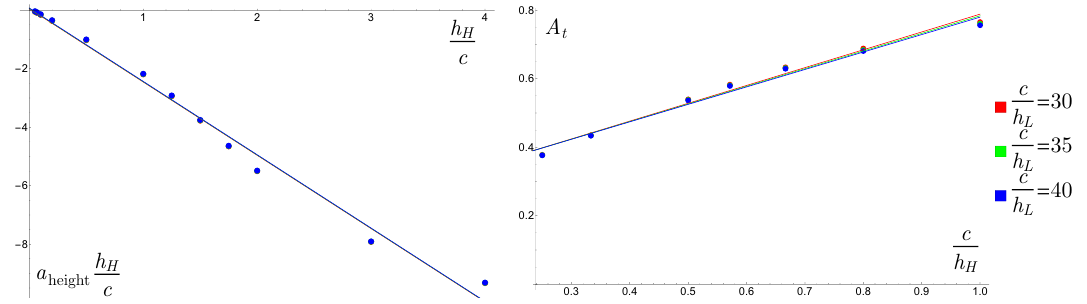
Figure 12 . We have found empirically that the time and height of the maxima of heavy-light Virasoro blocks have a simple dependence on both h and h H . This (cid:12)gure shows linear (cid:12)ts used to obtain the parameters a height and A t de(cid:12)ned in equations (3.6) and (3.5). These plots both have c = 10. Each point is obtained from the slope of log j (cid:11) h respectively (we’ve used points with h j j